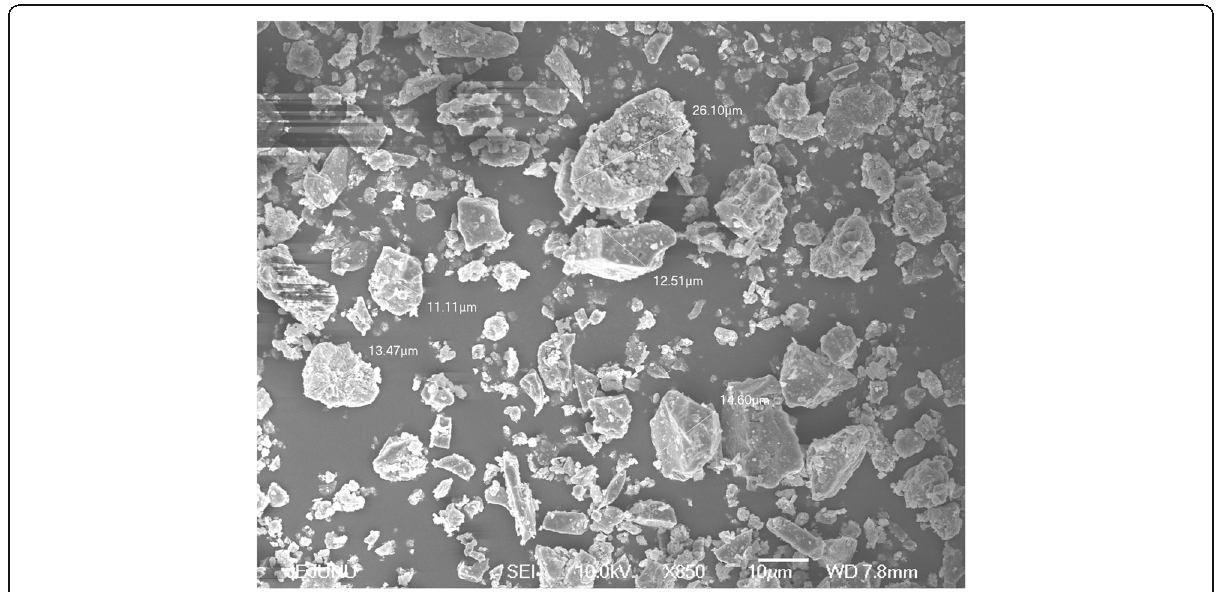
Fig. 1 Scanning electron microscope image of fine dust (FD) particles. CRM No. 28 Urban Aerosols, purchased from the National Institute for Environmental studies, Ibaraki, Japan. Scale bar: 10 μ